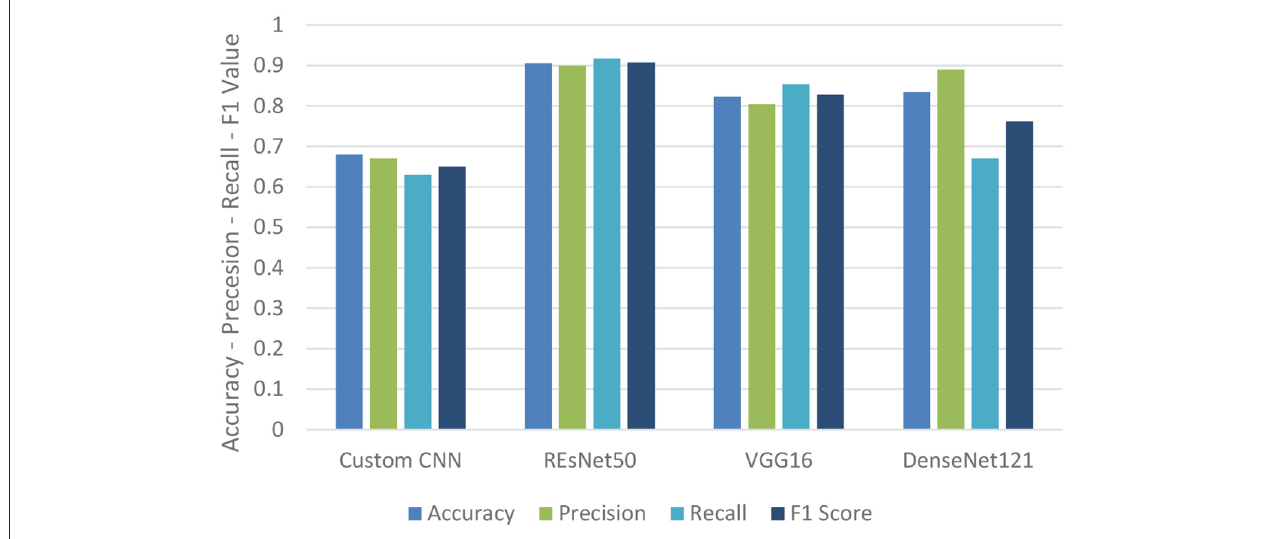
FIGURE 4 | Performance metrics table for binary classification (Haritha et al., 2020a).